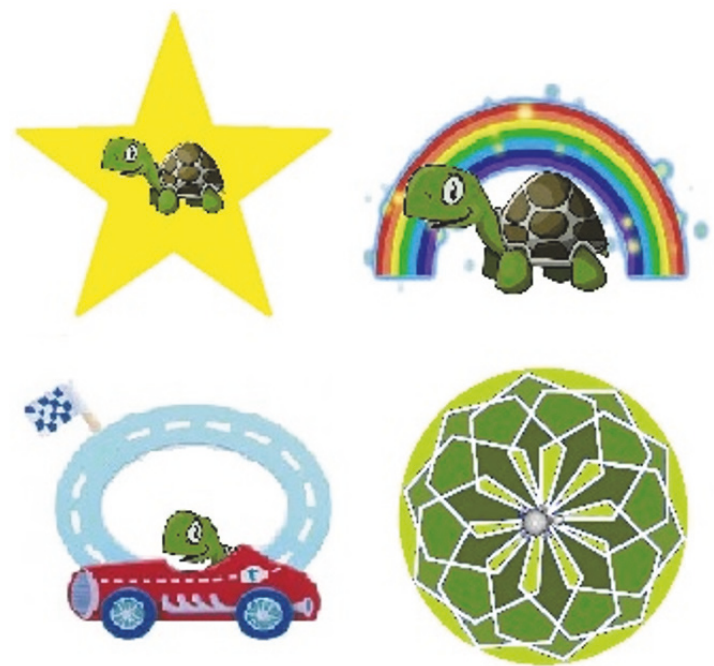
Figure 9: Several badges created for this course.